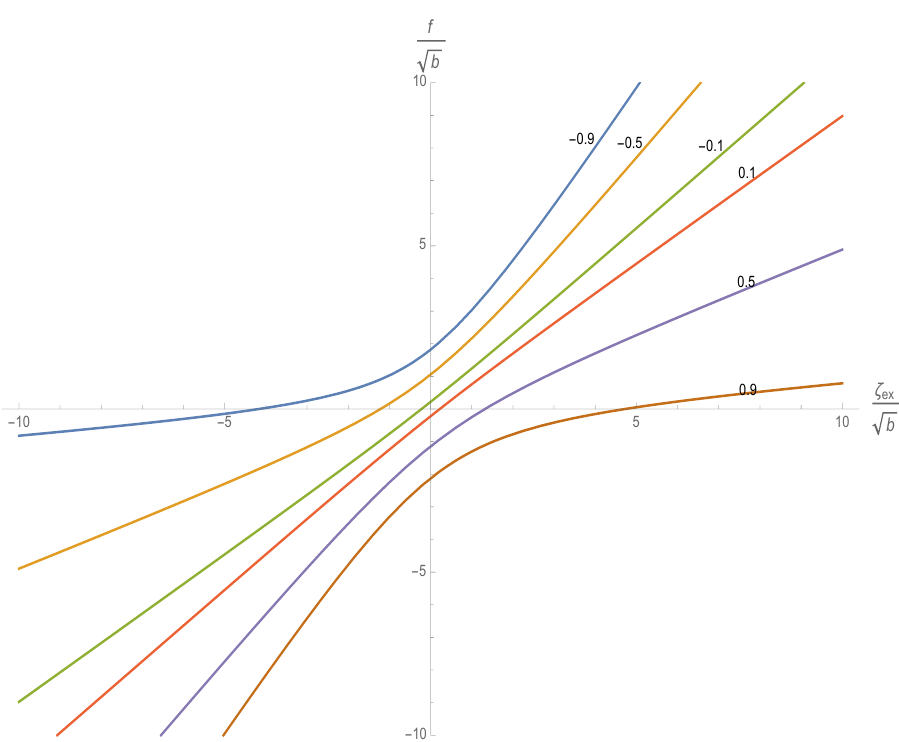
Figure 1. Here we have plotted f de(cid:12)ned in (4.118) for di(cid:11)erent values of (cid:21) F that are mentioned by the side of each curve. This qualitative behaviour is valid for both positive and negative bands including exceptional